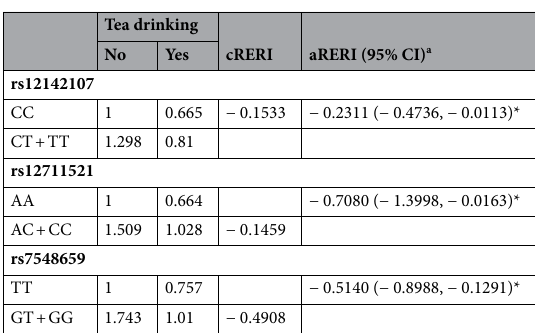
Table 2. Impact of interactions between MASP2 SNPs and tea drinking on the incidence of TB. *p < 0.05. a A multivariate logistic regression model was used to adjust for the covariates of sex, age, marital status, educational background, BMI, alcohol drinking, smoking, and BCG